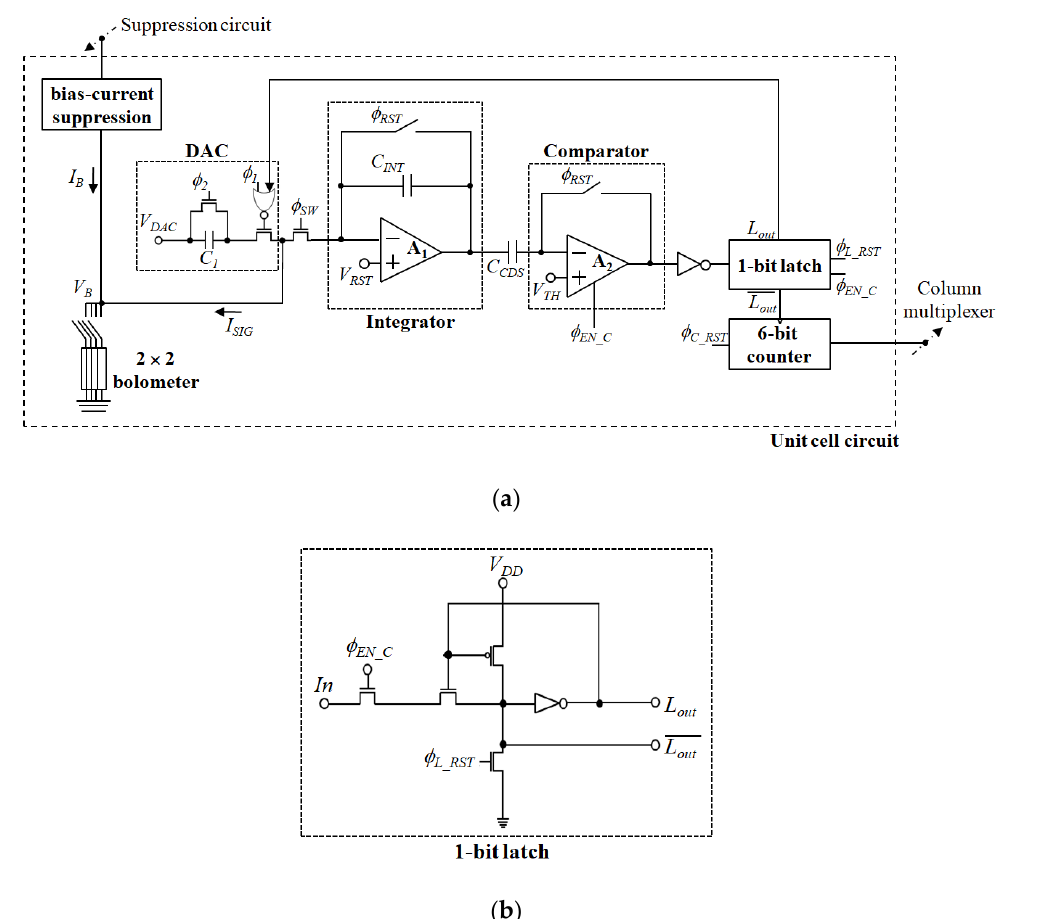
Figure 2. Schematic diagram of the proposed ADC: ( a ) overall unit cell circuit; ( b ) one-bit latch used in unit cell circuit.